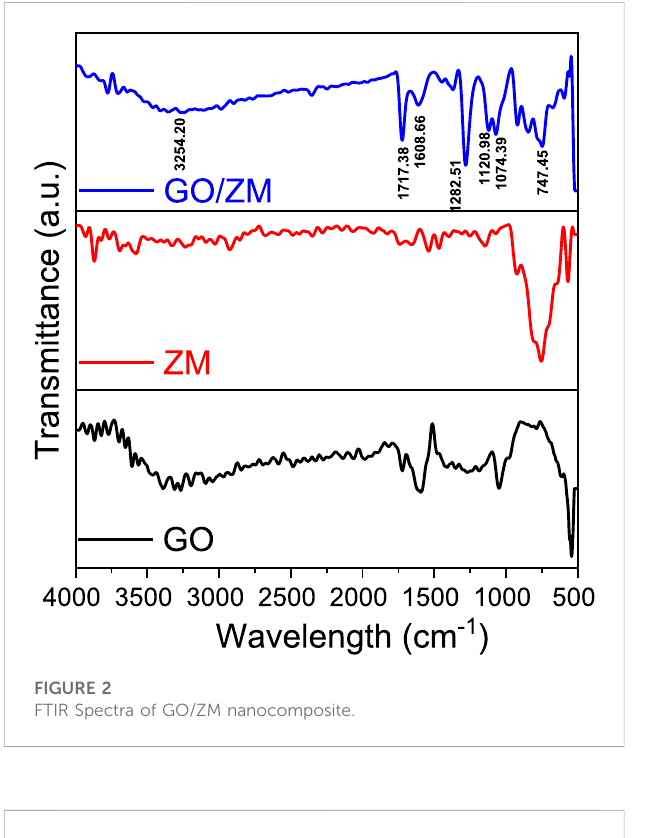
FIGURE 4 UV-vis spectra of GO, ZM and